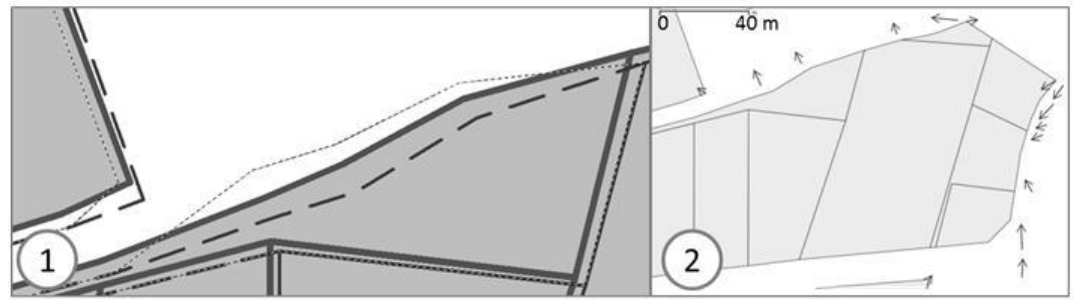
Figure 21. ( 1 ) Comparison of the least squares based conflation (in plain colors), the rubber sheeting conflation (with dots) and the initial data (with dashes); ( 2 ) a broader view of the initial data with deformation